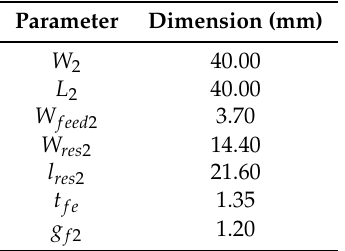
Table 2. Dimension of the hairpin resonator.